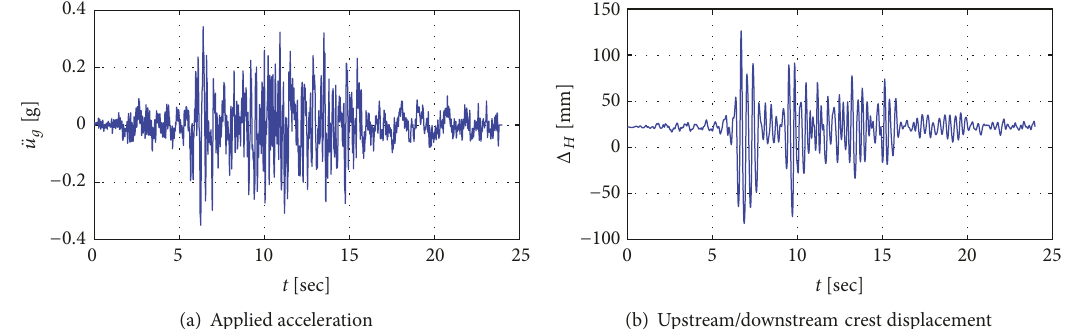
Figure 6: Structural analysis of pilot model.